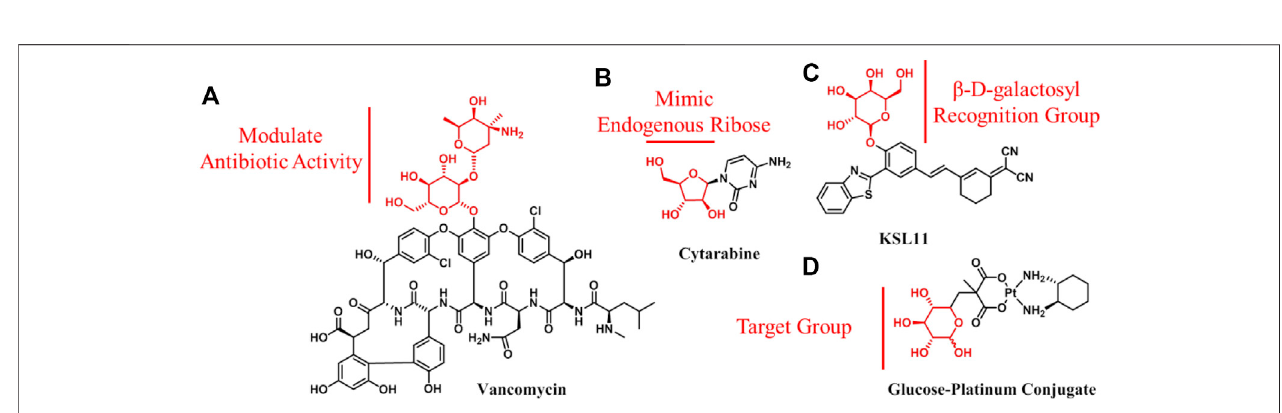
FIGURE 4 | Structures of carbohydrate conjugates: (A) Vancomycin used as an anti-infection agent; (B) nucleoside analog, cytarabine; (C) fl uorescence probe of human senescence-associated β -galactosidase with potential diagnostic application; (D) carbohydrate, as a target group, is used to design anticancer agents.